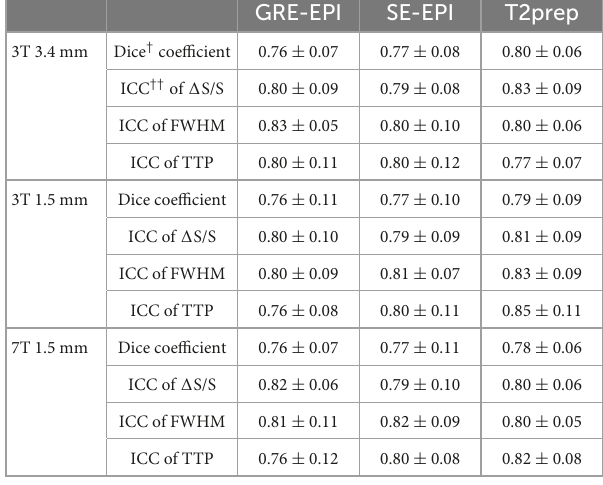
TABLE 3 Reproducibility of activation maps and hemodynamic response functions (HRF) in gradient-echo (GRE) echo-planar-imaging (EPI), spin-echo (SE) EPI, and T2-prepared (T2prep) blood oxygenation level dependent (BOLD) functional magnetic resonance imaging (fMRI) ( n =